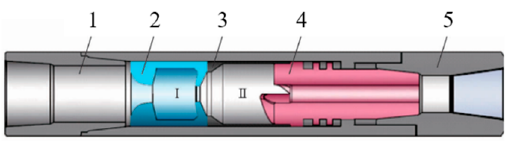
Figure 17. Schematic of the composite impactor. 1—upper sub; 2—nozzle; 3—shell; 4—load trans- mission rod; 5—lower sub; Ⅰ , and Ⅱ —Helmhol tz cavity